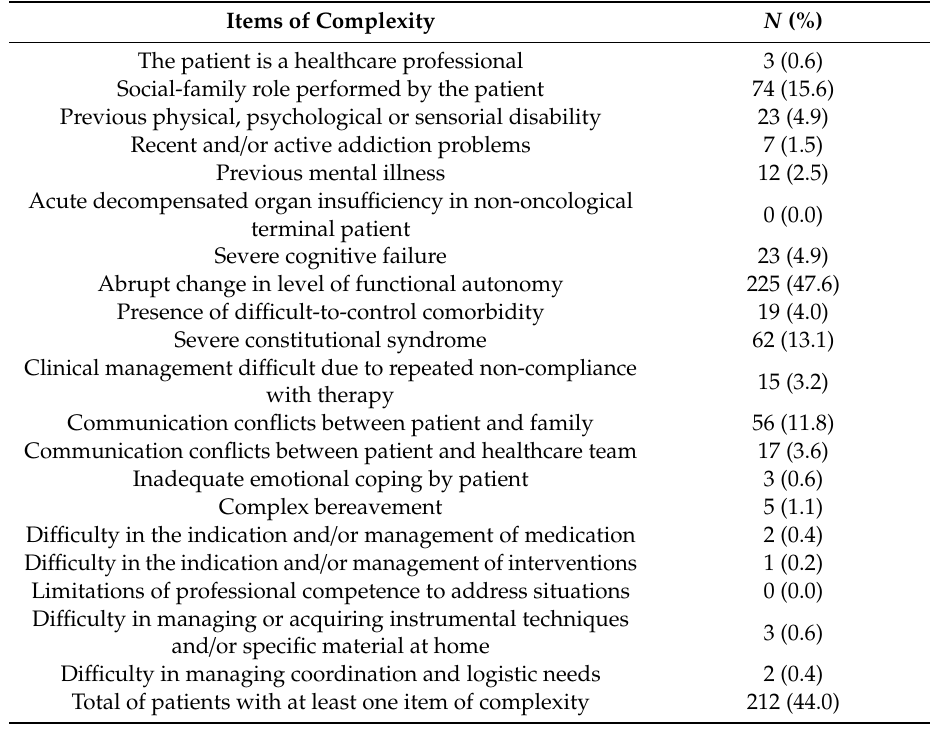
Table 3. Number of patients with a complex situation, according to IDC-Pal ©